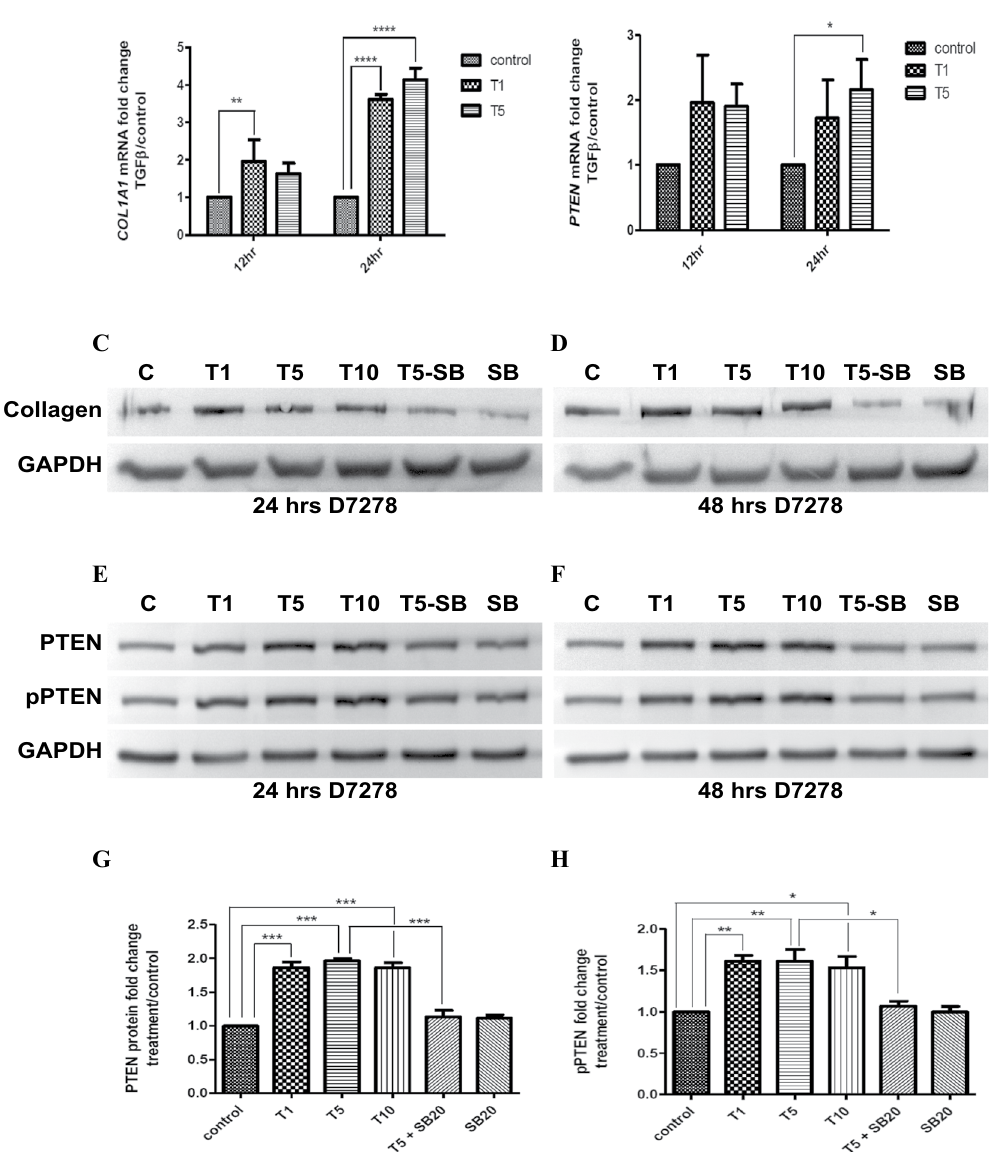
Figure 1. TGF- β induces an increase in levels of PTEN and its phosphorylation in human TM cells. ( A,B ) Real-time PCR analysis of COL1A1 and PTEN mRNA levels in TM cells treated with TGF- β 2 (1 or 5 ng/ml). RNA was extracted at 12 and 24 h. mRNA expression levels were normalized to EUK18S. A two-way ANOVA with Bonferroni’s post-hoc was used to determine statistical significance. * p < 0.05, ** p < 0.01, **** p < 0.0001. N = 3. ( C,D ) Western blot analysis of collagen levels in TM cells treated with TGF- β (T1, T5, T10 indicates 1, 5 or 10 ng/ml TGF- β 2). Protein was extracted at 24 and 48 h. TGF- β receptor signaling was inhibited using the inhibitor SB431542 (SB; 20 μ M). D7278- representative human donor. ( E,F ) Western blot analysis of PTEN levels and its phosphorylation (pPTEN- ser380/thr382/383) in TM cells treated with TGF- β and SB431542. Protein was extracted at 24 and 48 h. D7278- representative human donor. ( G,H ) Densitometry was performed on PTEN and pPTEN Western blot data at 48 h using ImageJ software. Statistical significance was determined using one-way ANOVA with Tukey’s post-hoc. * p < 0.05, ** p < 0.01, *** p < 0.001. N = 3. (I,J). TGF- β - mediated induction of PTEN levels and its phosphorylation was confirmed in TM cells from an adult human donor, aged 26 yrs (Adult